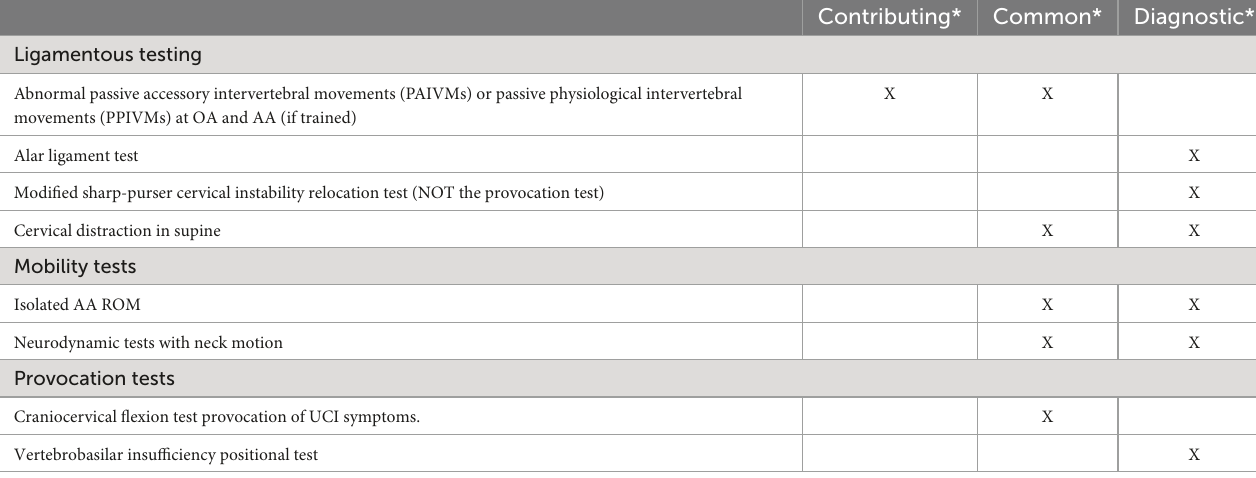
Contributing* Common*